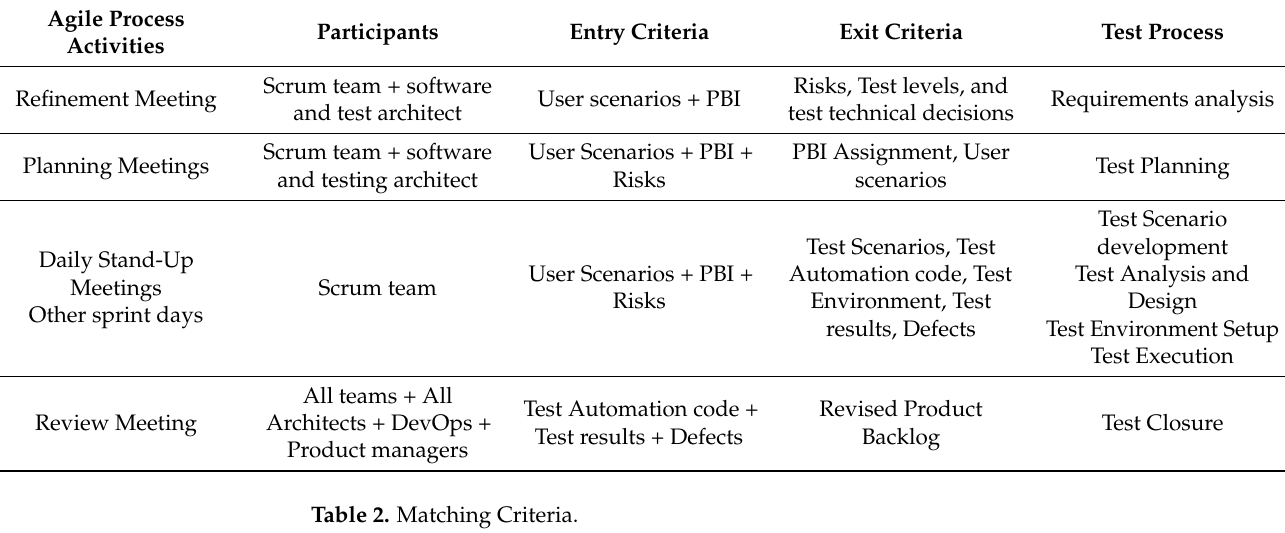
Table 1. Test Processes and SAFE Activity Integration.